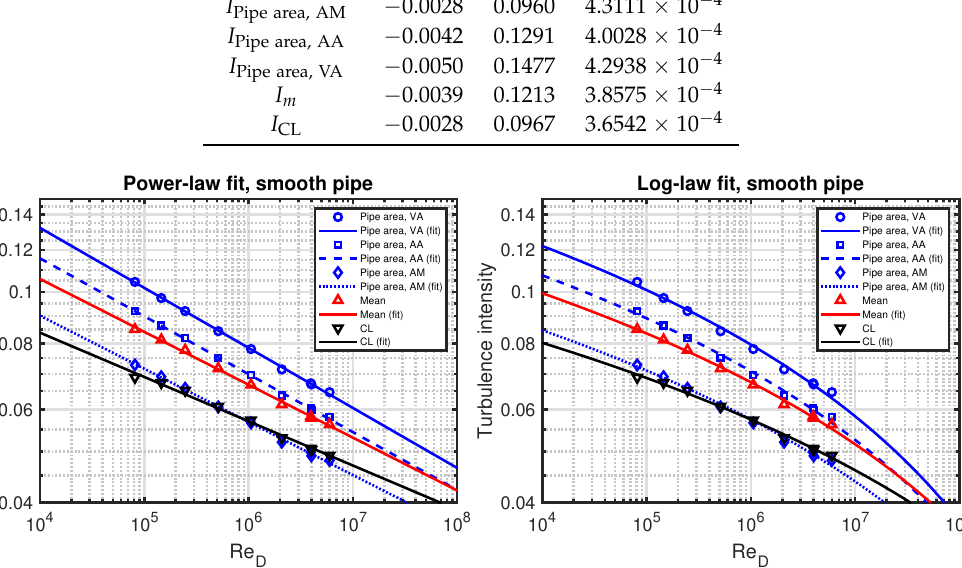
Figure 4. Smooth pipe turbulence intensity as a function of Re D , left: Power-law fit, right: Log-law fit.